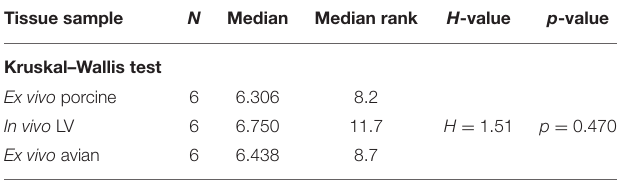
TABLE 1 | Statistical